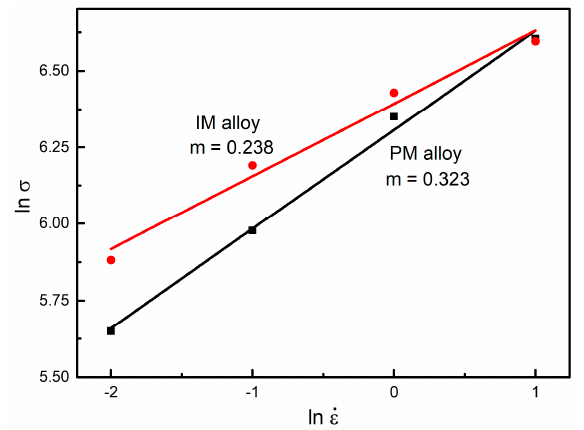
Figure 9. Comparison of the flow stress of the PM and the IM Ti-5553 alloys, at 700 °C, and various strain rates: ( a ) peak stress; and ( b ) steady-state stress ( ε = 1.2).